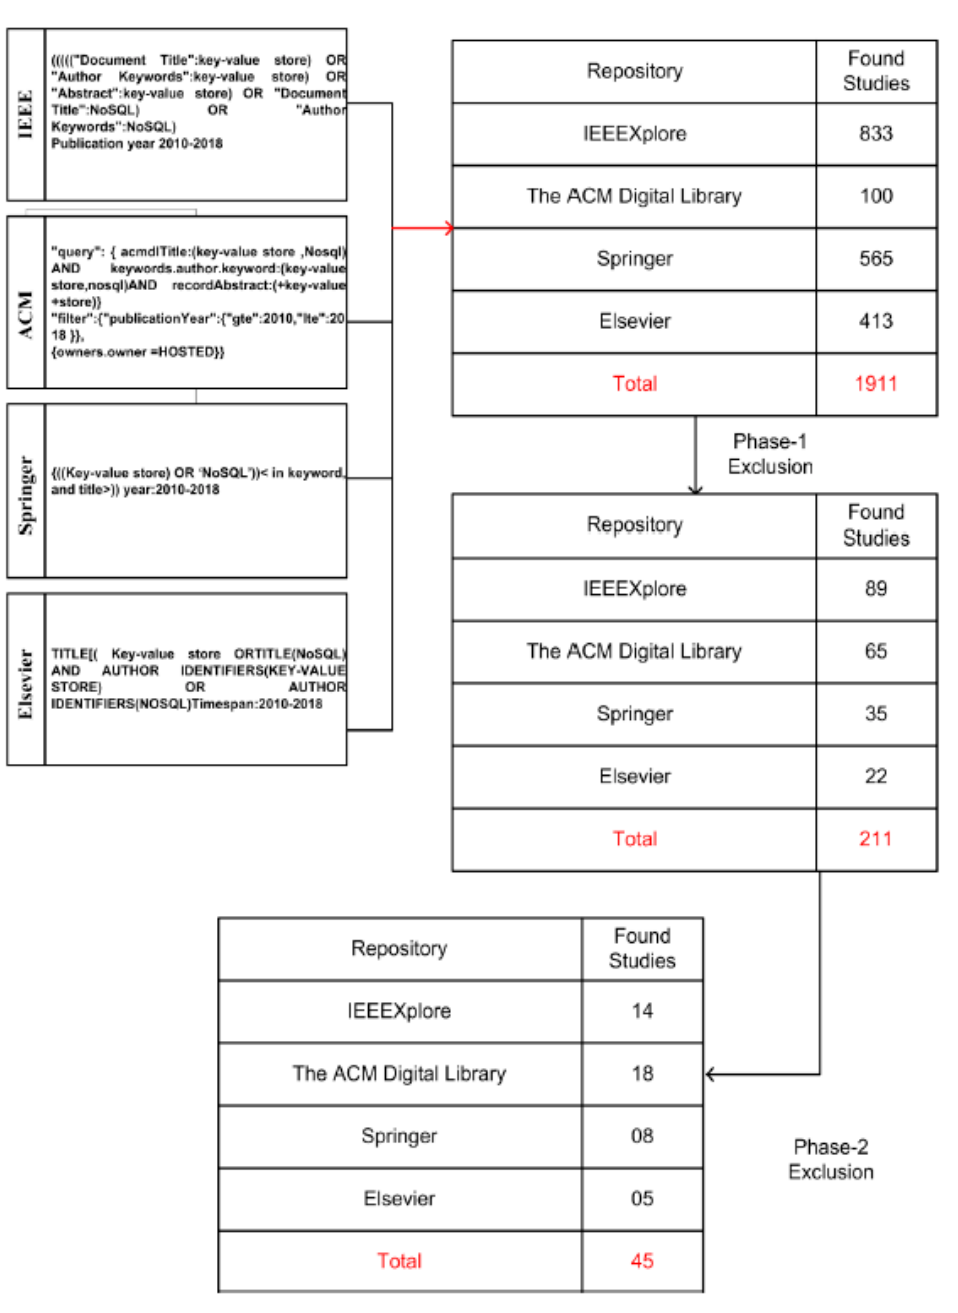
Figure 4. Study selection process.